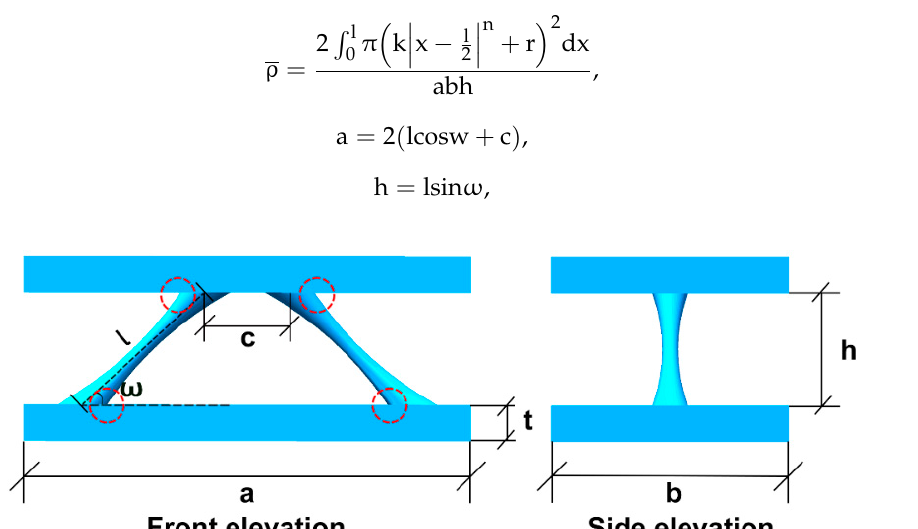
Figure 2. 2-D lattice structure with the variable cross-section core unit cell schematic illustration.